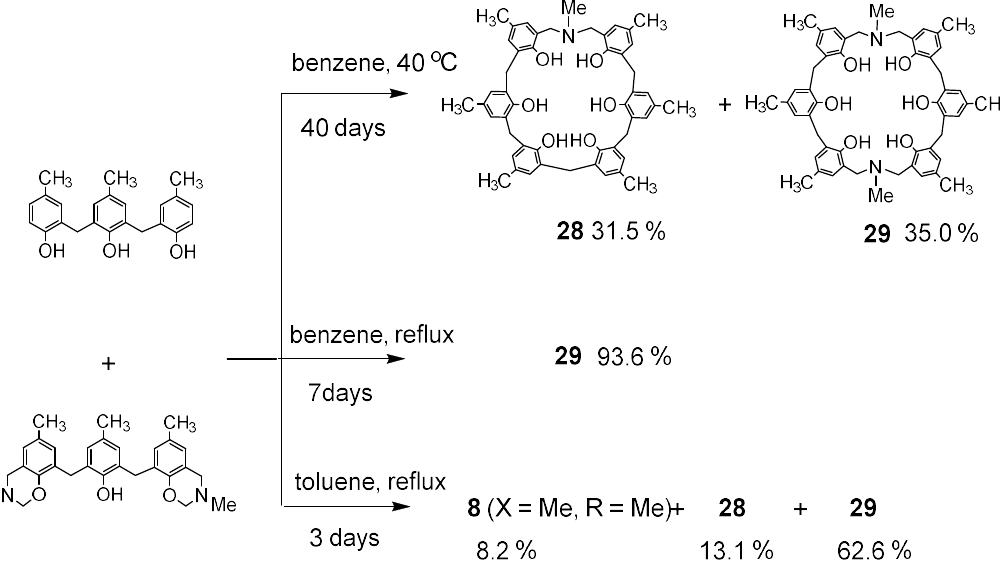
Scheme 13. Reaction products between phenol trimer and benzoxazine 26b .